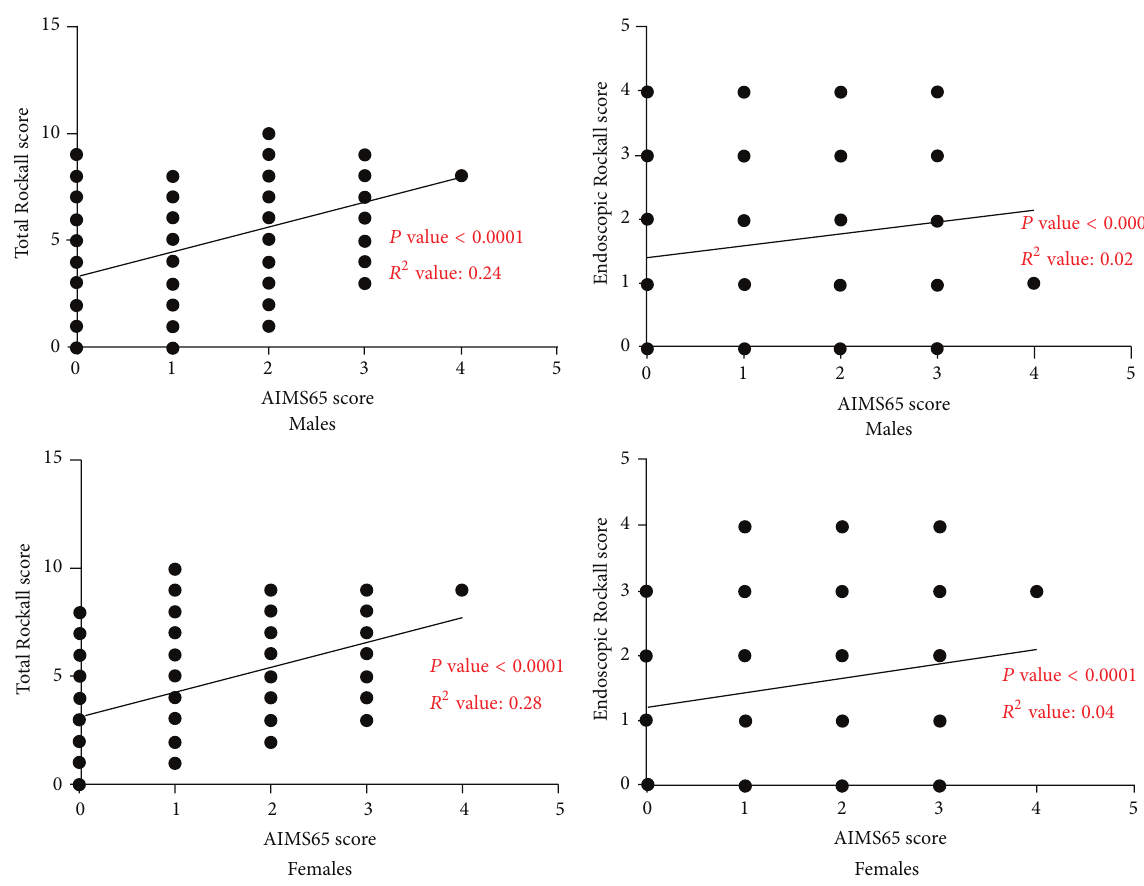
Figure 2: Statistically significant correlation was found between Total Rockall/EndoscopicRockall scores and AIMS65 scores in both genders.